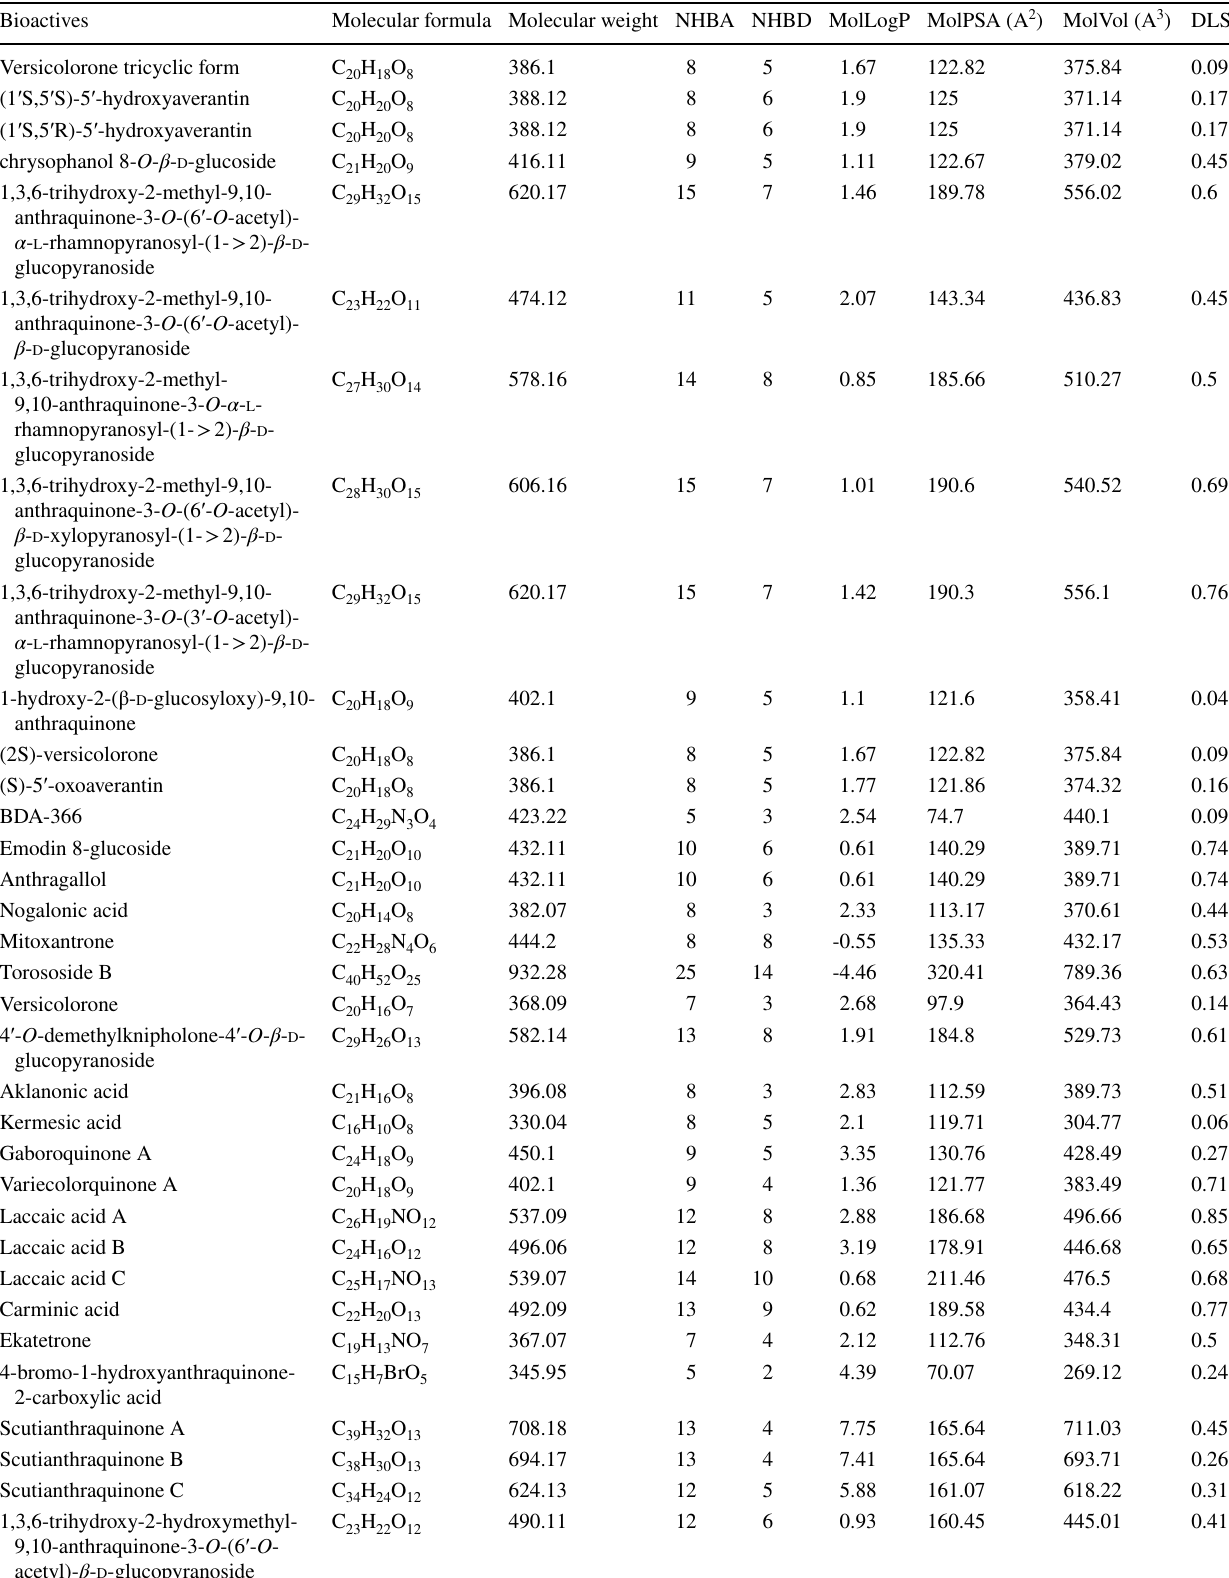
Table 1 Druglikeness of anthraquinone derivatives with positive score